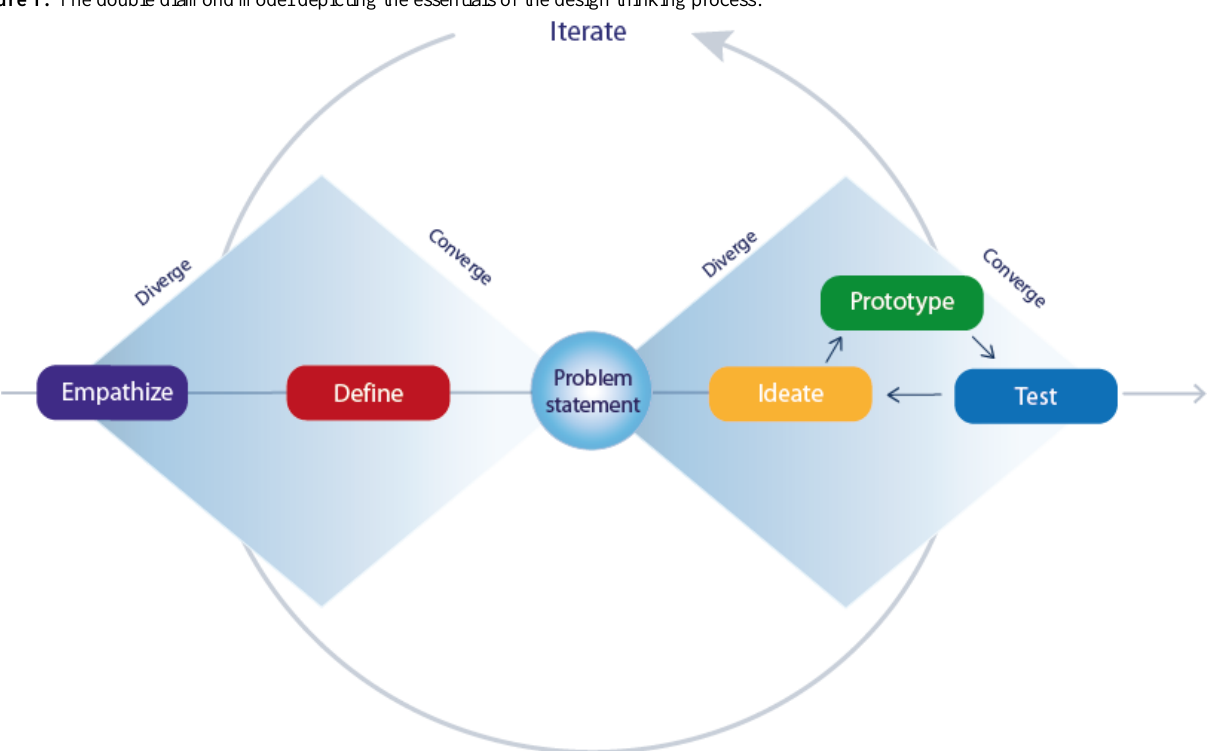
Figure 1. The double diamond model depicting the essentials of the design thinking